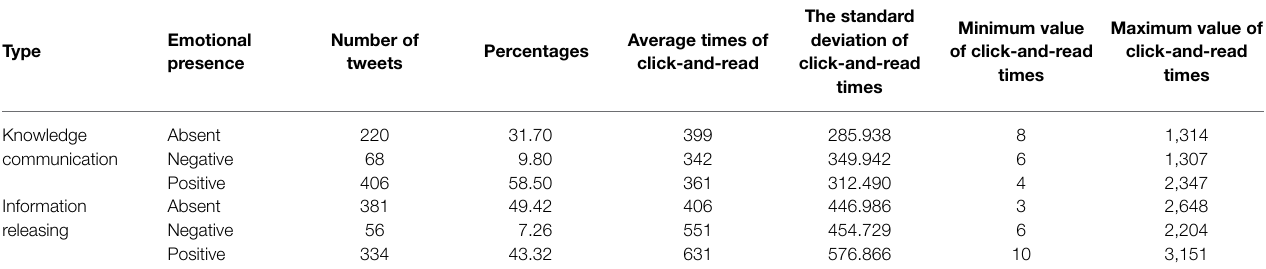
TABLE 2 | Descriptive statistics of emotional information in tweet titles of WeChat public accounts for knowledge communication and information releasing.